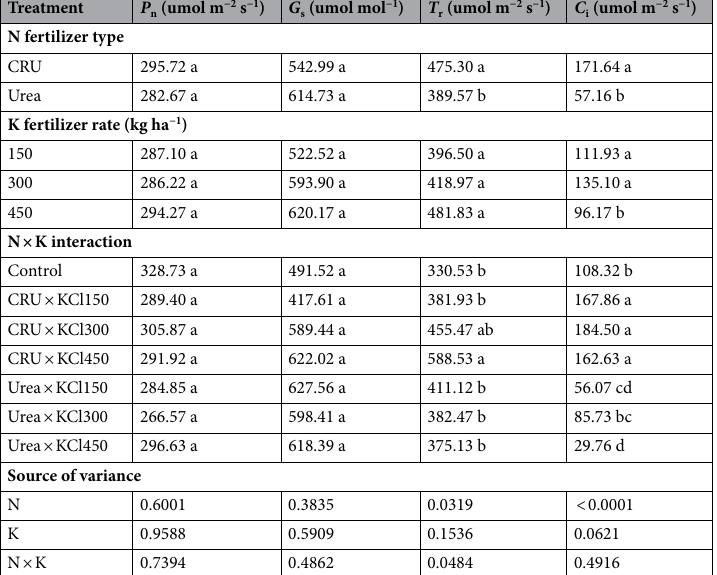
Treatments Root volume (cm 3 ) Tips